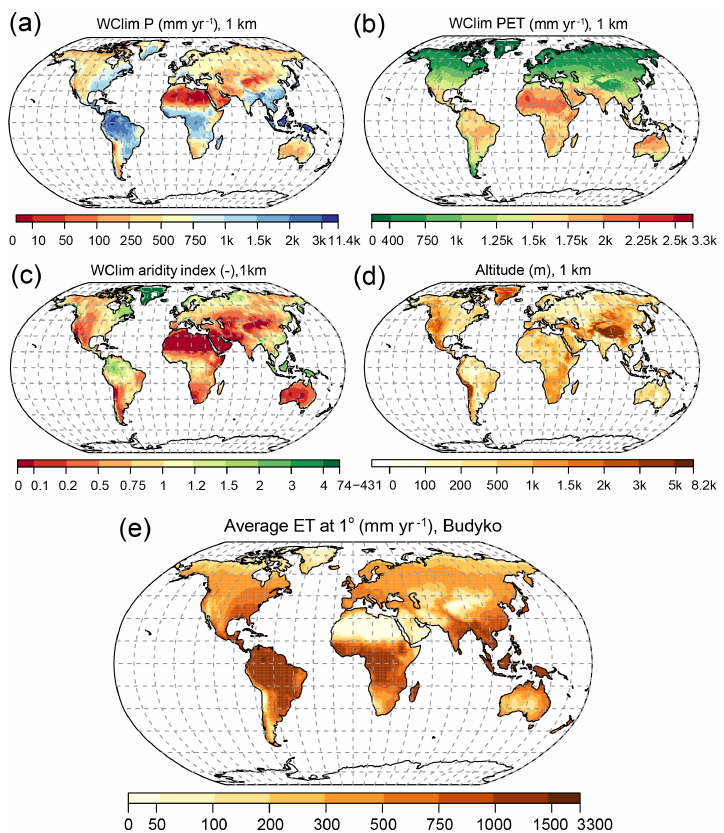
Figure 2. Global distribution of 1km resolution annual mean precipitation ( a : P ; WorldClim; Hijmans et al., 2005), potential evapotranspi- ration ( b : PET; WorldClim; Hijmans et al., 2005), the aridity index ( c : AI = P/ PET; WorldClim; Hijmans et al., 2005), and topography ( d : Shuttle Radar Topography Mission – SRTM; Jarvis et al., 2008), along with (e) evapotranspiration (ET) at a 1 ◦ × 1 ◦ scale by averaging 1km values of ET calculated using the Budyko function (Eq. 1). WClim: